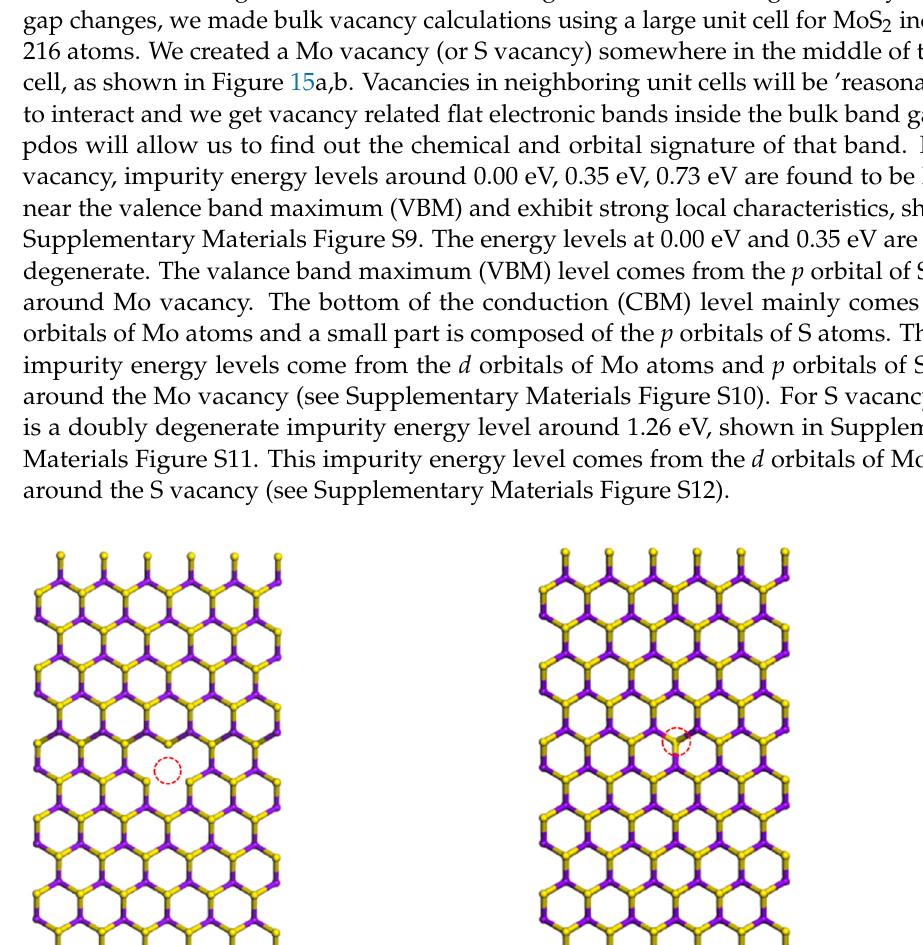
Figure 14. The relaxed geometry, band structure and dos of symmetric and asymmetric (MoS 2 ) 3 /(WS 2 ) 3 armchair nanorib- bons with Mo vacancy. ( a ) symmetric structure with inside Mo vacancy and ( b ) symmetric structure with edge Mo va- cancy. ( c ) asymmetric structure with inside Mo vacancy and ( d ) asymmetric structure with edge Mo vacancy.